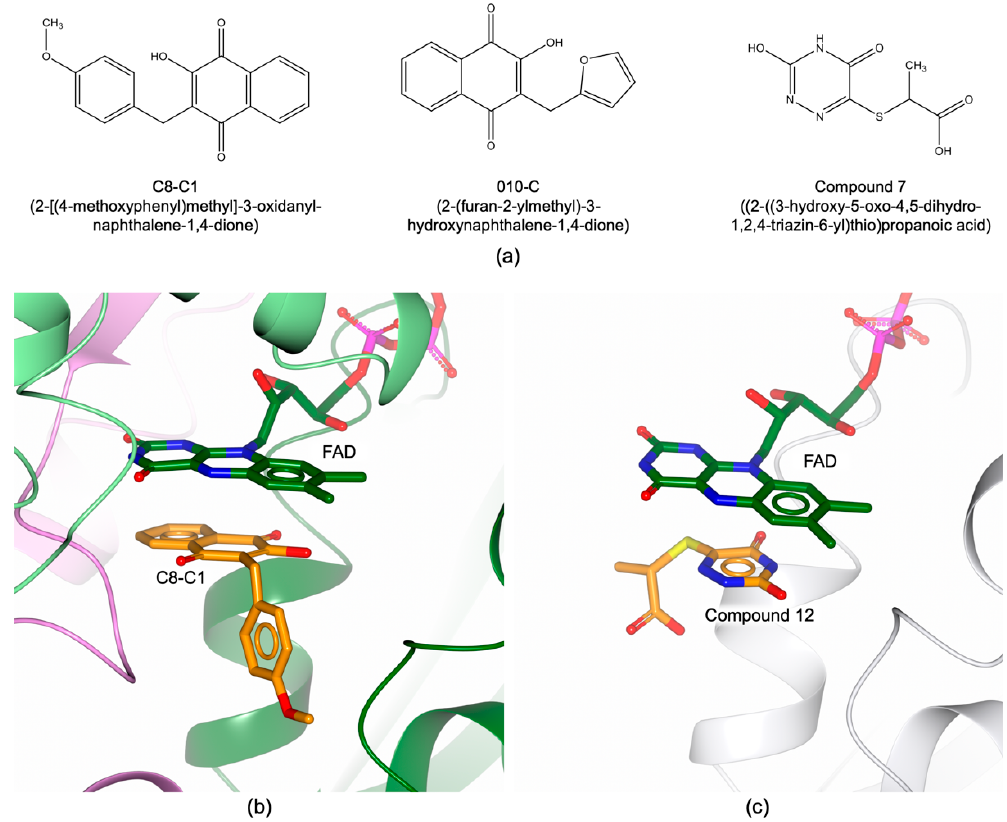
Figure 8. ( a ) Chemical structures of FDTS inhibitors. ( b ) Binding mode of the NQ derivative C8 - C1 (in sticks, orange carbons) in the active site of PBC V1FDTS (in cartoon, Subunit A is colored dark green, B light green, and C pink; FAD in sticks, dark green carbons; PDB id 4FZB [56]). ( c ) Binding mode of Compound 12 (in sticks, orange carbons) in the active site of Tm FDTS ( white cartoon; FAD in sticks, dark green carbons; PDB id 5CHP [58]).